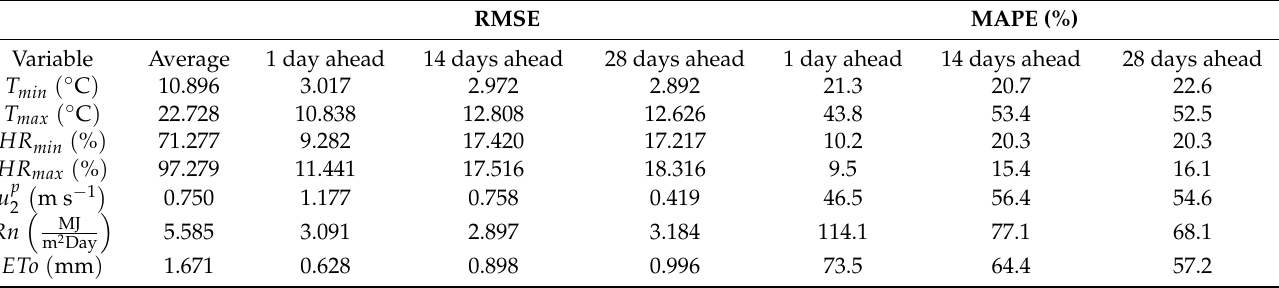
Table 3. Results for the winter